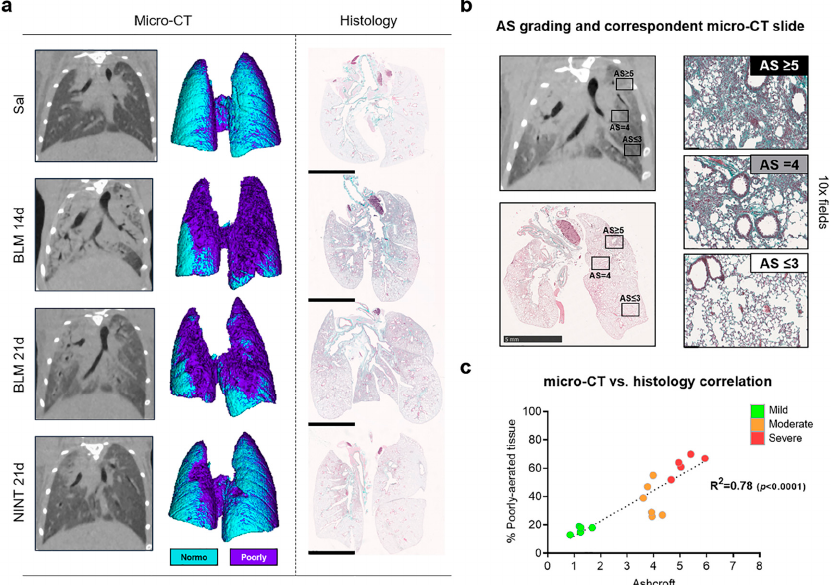
Figure 1. ( a ) For each treatment group, representative coronal 2D micro-CT lung slices are followed by their relative 3D renderings (on the left) and representative whole lung sections are stained with Masson’s trichrome (on the right). In micro-CT renderings, cyan represents the normally aerated tissue while purple regions correspond to poorly aerated tissue; ( b ) Side-by-side comparison between micro ‐ CT and histomorphometric readouts with the identification of different degrees of severity by Ashcroft score. ( c ) A simple linear regression comparing the average Ashcroft score with the % of poorly aerated tissue for each mouse ( p < 0.0001). Green, orange, and red colors represent the three categories (mild, moderate and severe) defined by the average Ashcroft score value. NINT—nintedanib; BLM—bleomycin; and AS—Ashcroft score.